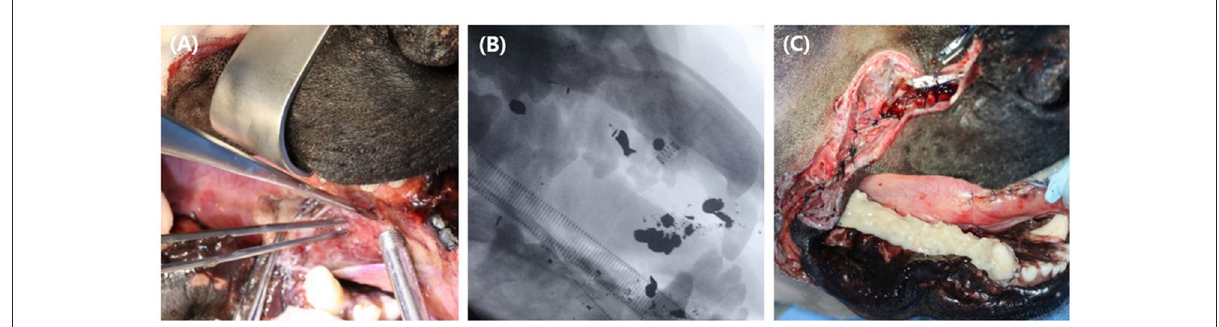
FIGURE2 Emergency surgery was performed to debride devitalized tissues, to extract as many bullet fragments as possible and to stabilize fractured bones temporarily. Extraction of the bullet fragments (A) were made under fluoroscopic guidance (B) . A continuous stout loop interdental wire was applied at the right mandibular teeth and the fixation was reinforced with temporary resin over the area (C)